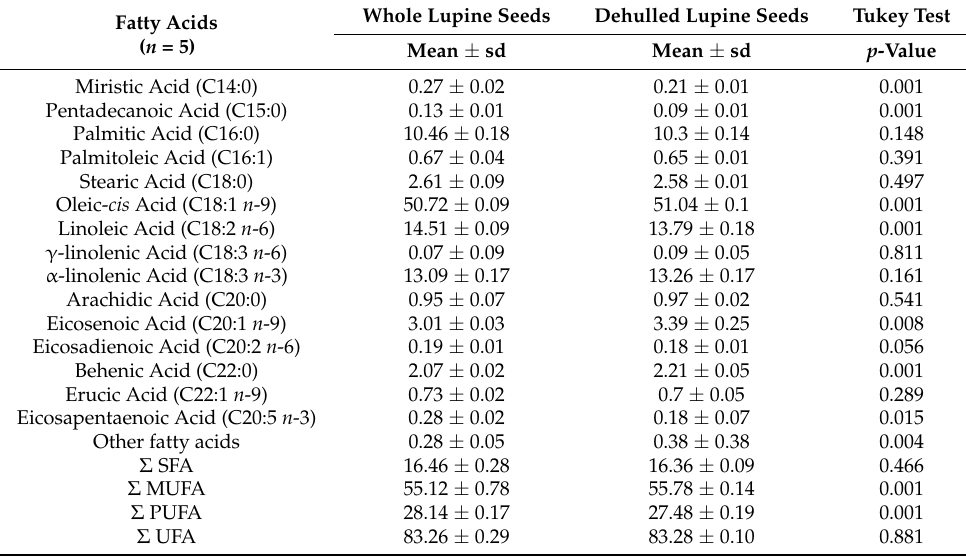
Table 3. Influence of dehulling L. albus (cultivar Amiga) seeds on the fatty acids content of fats (% of